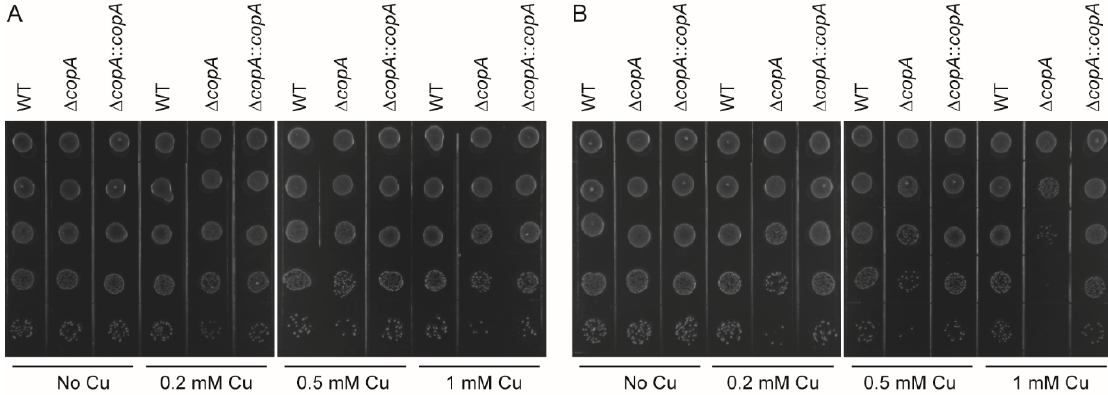
Figure 6. CopA protects S. suis against copper-mediated bactericidal effect. The WT, Δ copA , and Δ copA :: copA strains were grown to an OD 600 of 0.6. Each culture was then divided into four equal volumes, which were treated with either varying concentrations of Cu (0.2, 0.5, and 1 mM) or deionized H 2 O. At 2 h ( A ) and 3 h ( B ), aliquots were removed, serially diluted 10-fold up to 10 − 5 dilution, and 5 µ L of each dilution was then spotted onto the plates from 10 − 1 (top) to 10 − 5 (bottom). The graphs are representative of three independent experiments.